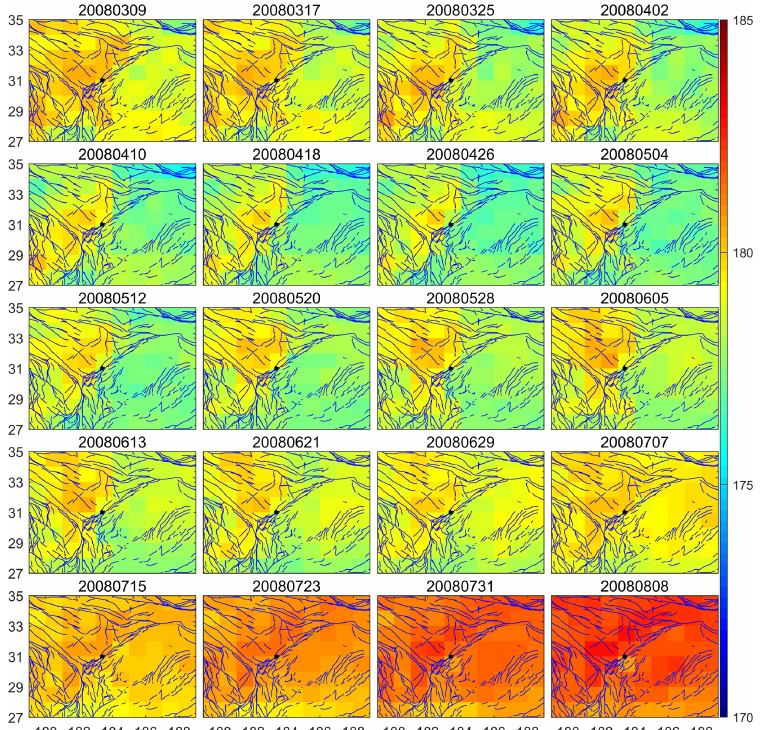
Figure 4. The 5-year (2003 to 2007) average distribution of 8d nighttime CH 4 VMR at 400hPa.